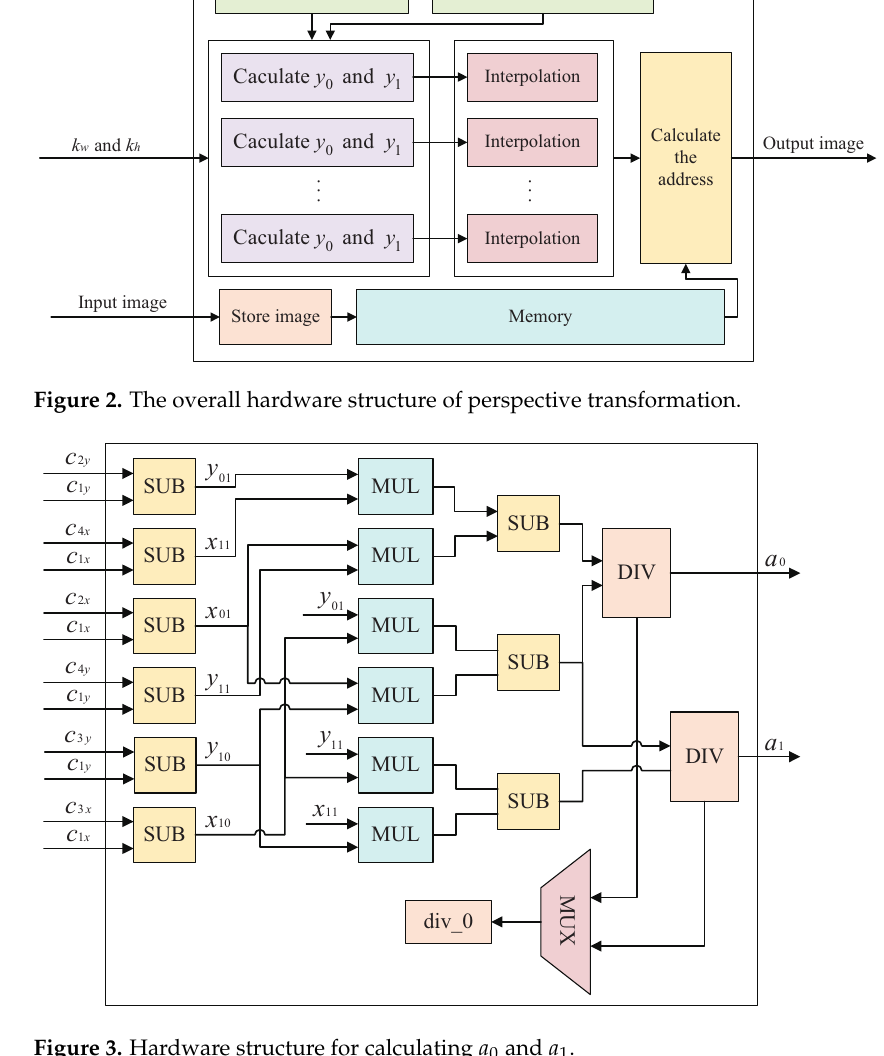
Figure 3. Hardware structure for calculating a 0 and a 1